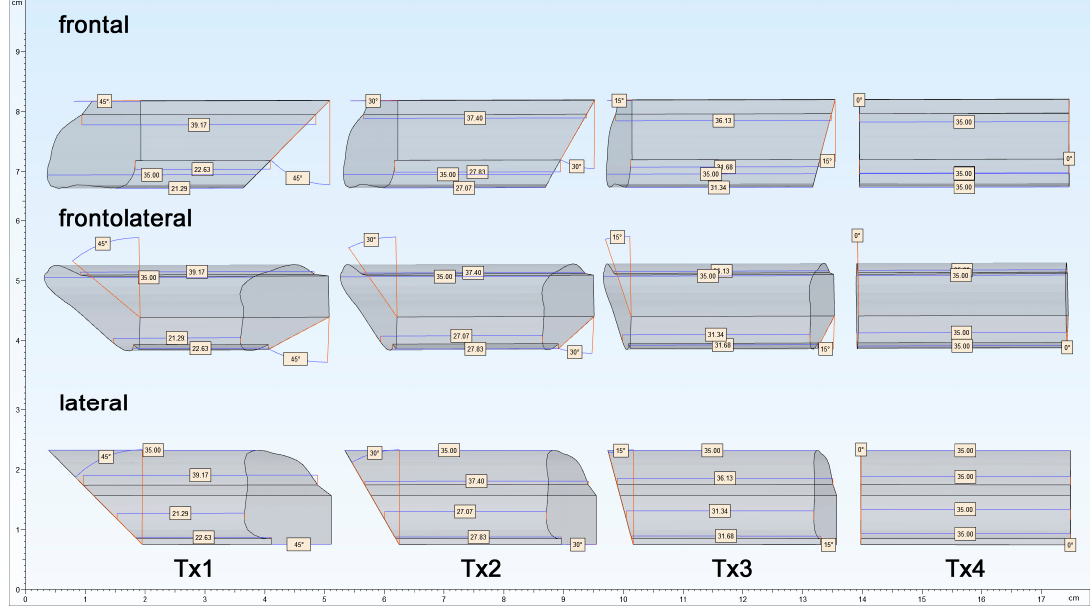
Figure 4. Original planning parameters, to be realized with both methods, with Tx1 (proximal) to Tx4 (distal) in frontal, frontolateral, and lateral views.